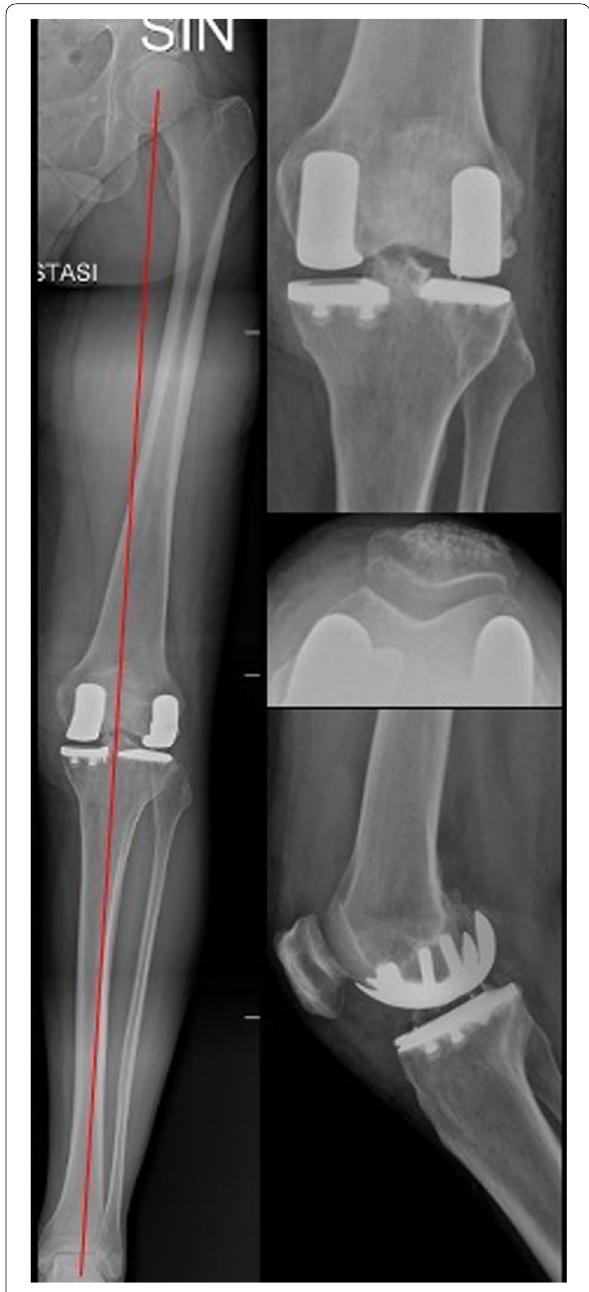
Fig. 7 Postoperative X-rays evaluation of the case in Fig. 1. It is possible to see the respect of the native morphotype and the different prosthetic components used in the medial and in the lateral